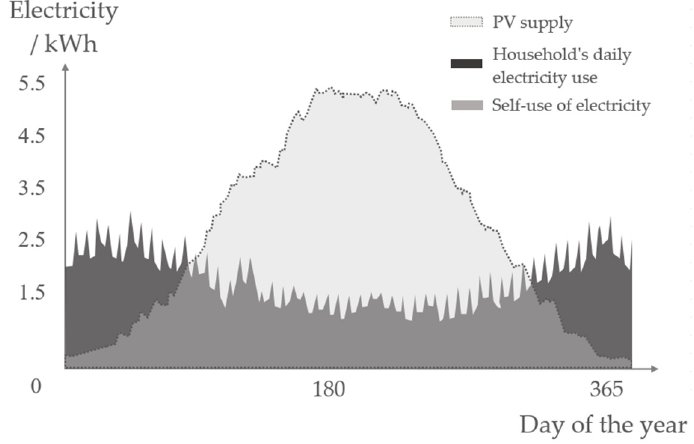
Figure 7. Daily electricity-use-to-PV-supply graph for an average of 1067 studied profiles with PV electricity produced in Karlstad.